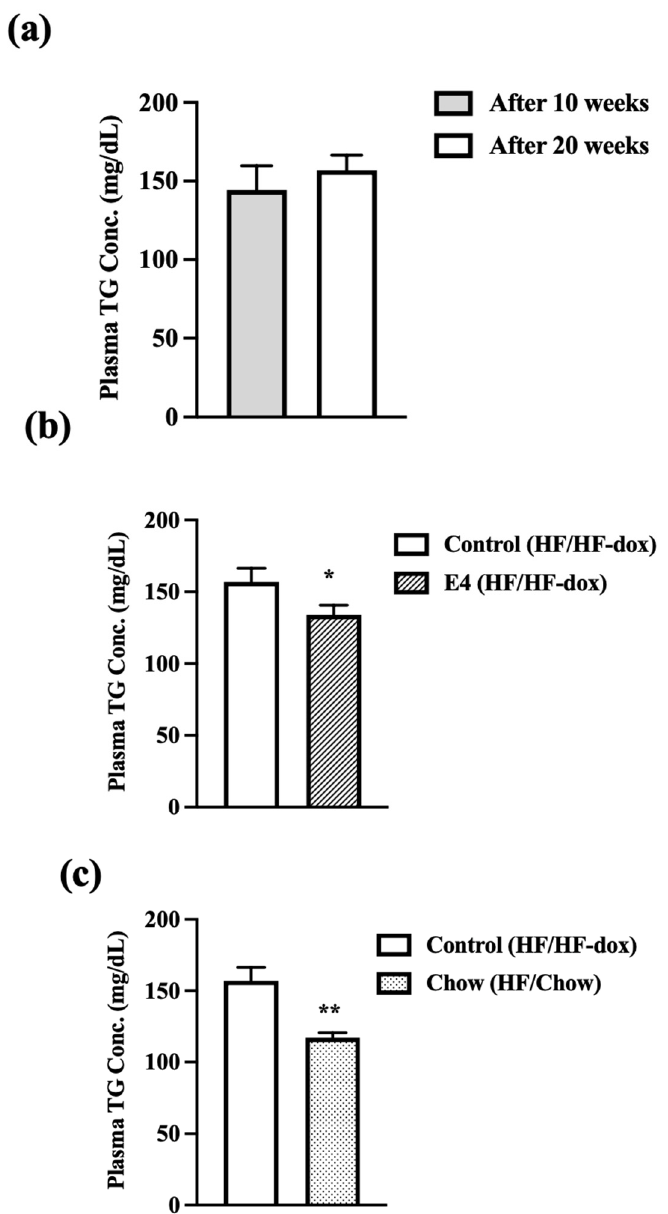
Figure 3. Plasma TG levels were measured after 10 and 20 weeks of high fat feeding in E4 and control mice and 10 weeks of diet reversal in chow mice. ( a ) Control mice do show any increase in plasma TG concentration after 20 weeks of HFD compared with post 10 weeks of HFD. Both ( b ) E4 and ( c ) chow group show significant reduction in serum TG content compared to control at 20 weeks. n = 5, Welch’s t -test: * p < 0.05, ** p <